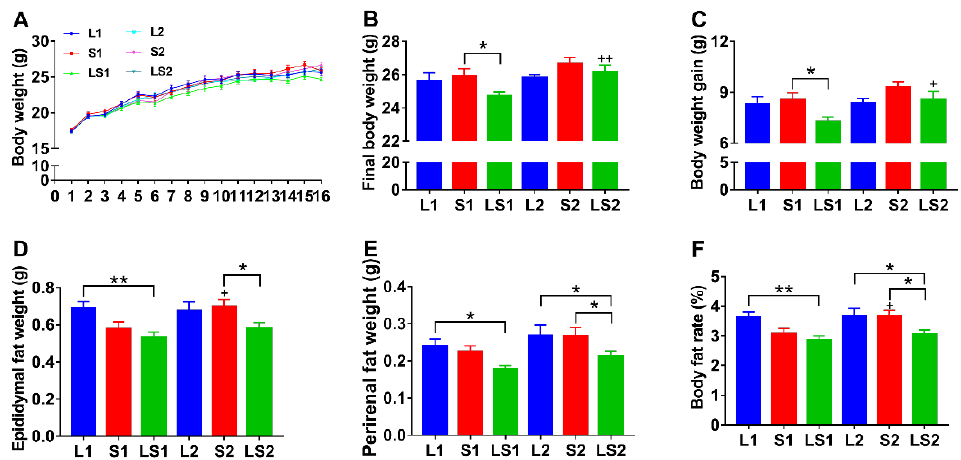
Figure 1. Impacts of various oil/fat diets on ( A ) body weight over 16 weeks, ( B ) final body weight, ( C ) body weight gain, ( D ) epididymal fat weight, ( E ) perirenal fat weight, ( F ) body fat rate. “*” denotes marked differences at p < 0.05; “**” denotes significant differences at p < 0.01; “+” shows marked differences at p < 0.05 relative to the same oil type with different energy level; “++” represents significant differences at p < 0.01 relative to the same oil type with different energy level.